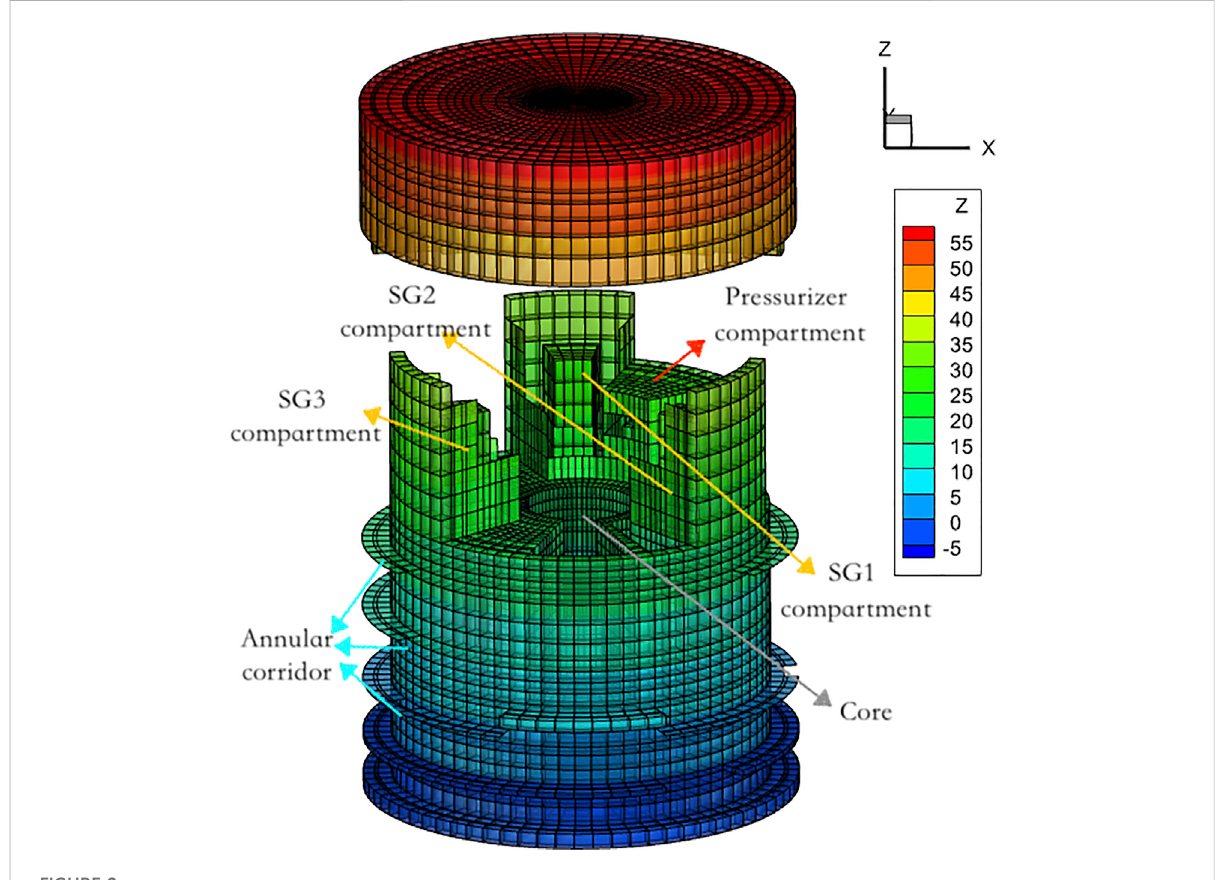
FIGURE 2 Overall structure of the